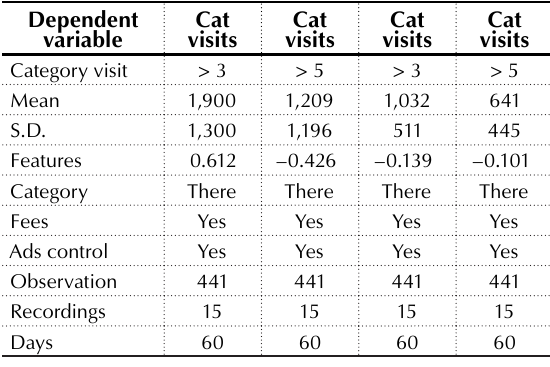
Table 2. The effect of ads on traffic category